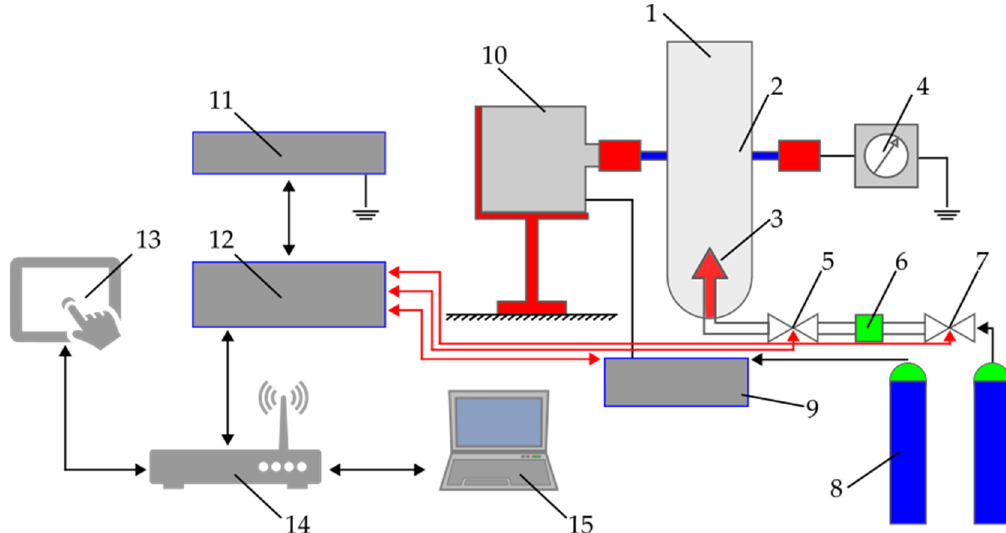
Figure 8. Scheme of Hartmann equipment [7]: (1) Hartmann tube, (2) electrodes, (3) nozzle, (4) micrometer, (5) outlet valve, (6) air reservoir, (7) inlet valve, (8) compressed air supply, (9) piston driver, (10) piston, (11) spark generator, (12) programmable logic controller, (13) human interface, (14) router, and (15) computer.